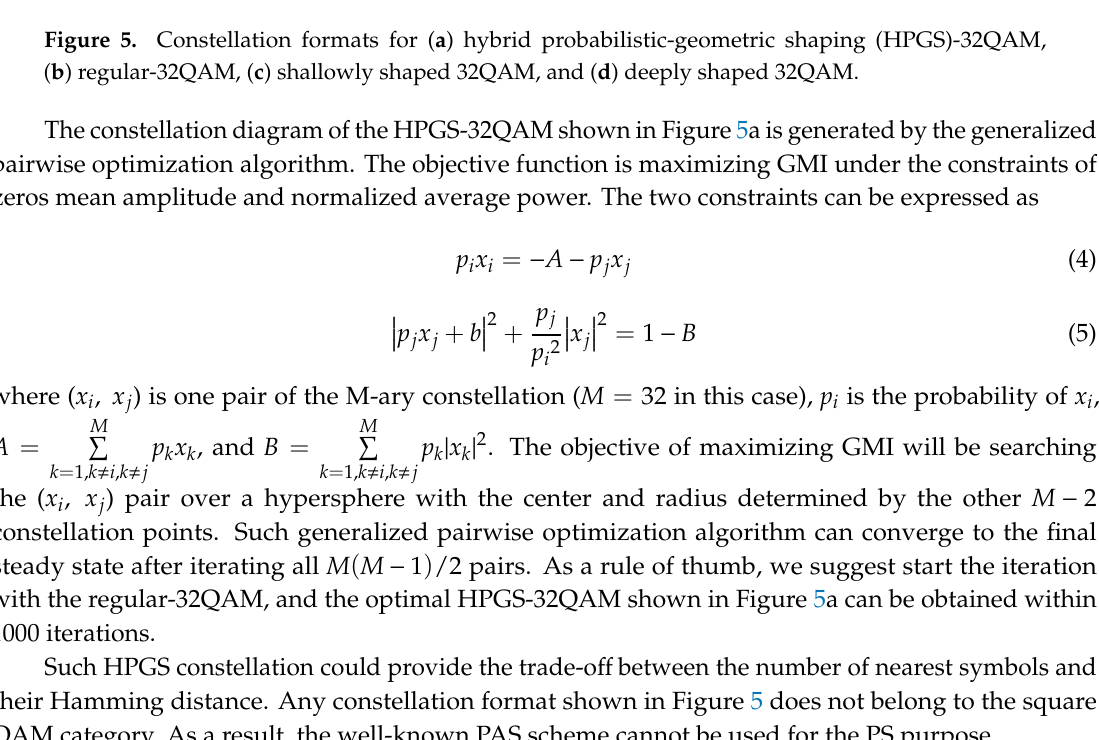
Figure 5. Constellation formats for ( a ) hybrid probabilistic-geometric shaping (HPGS)-32QAM, ( b ) regular-32QAM, ( c ) shallowly shaped 32QAM, and ( d ) deeply shaped 32QAM.